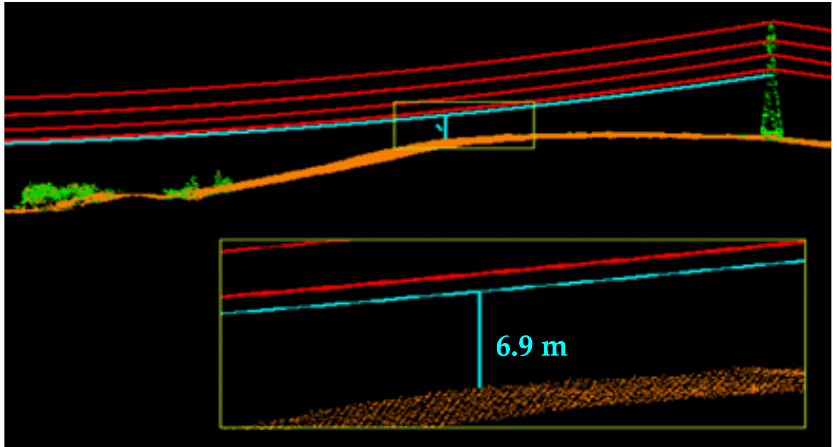
Figure 3. The minimum height of the conductor above the terrain after the recalculation of its position from initial conductor temperature of +10 °C to temperature of +40 °C.